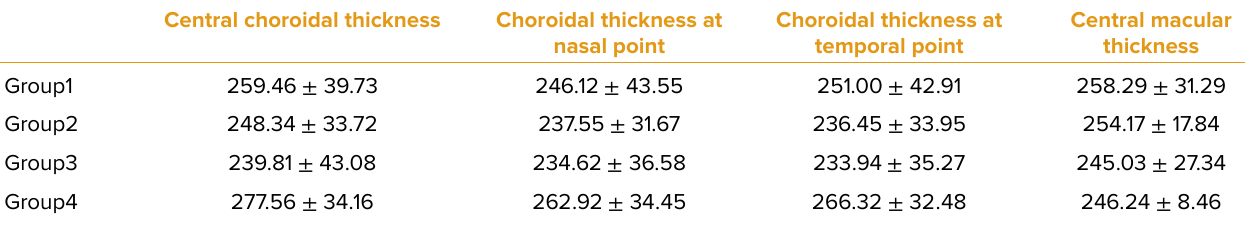
Table 3. The mean choroidal and central macular thickness in all study